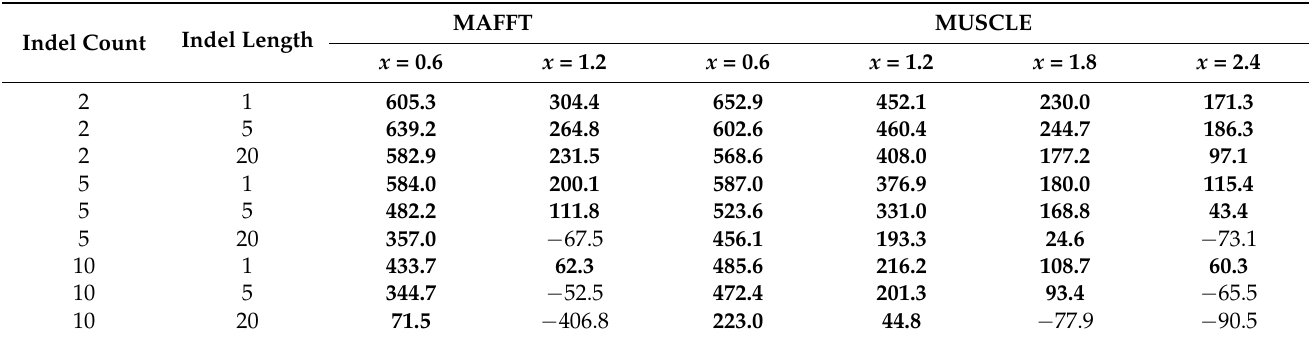
Table 5. Z values calculated for multiple alignments of 81 Des sets constructed using MAFFT and MUSCLE ( Z values > 10.0 are in bold).